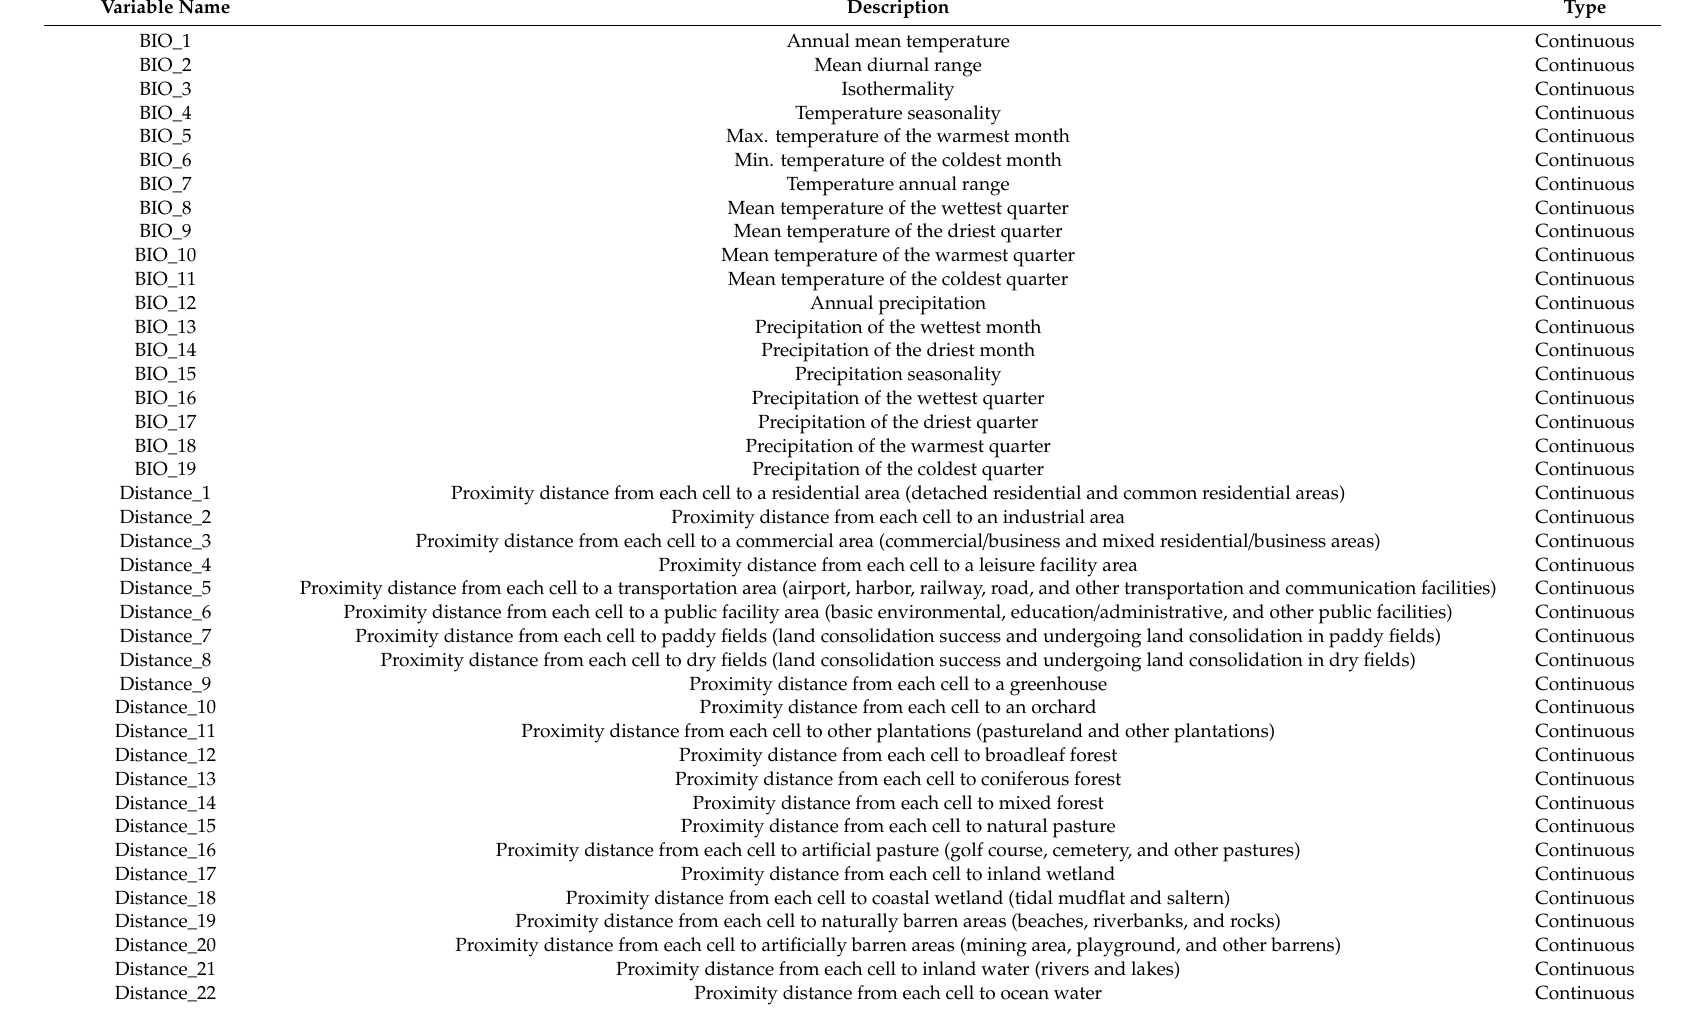
Table 3. List of input